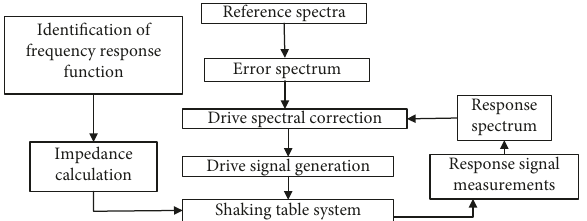
Figure 7: Schematic diagram of control algorithm for power spectrum of PSD